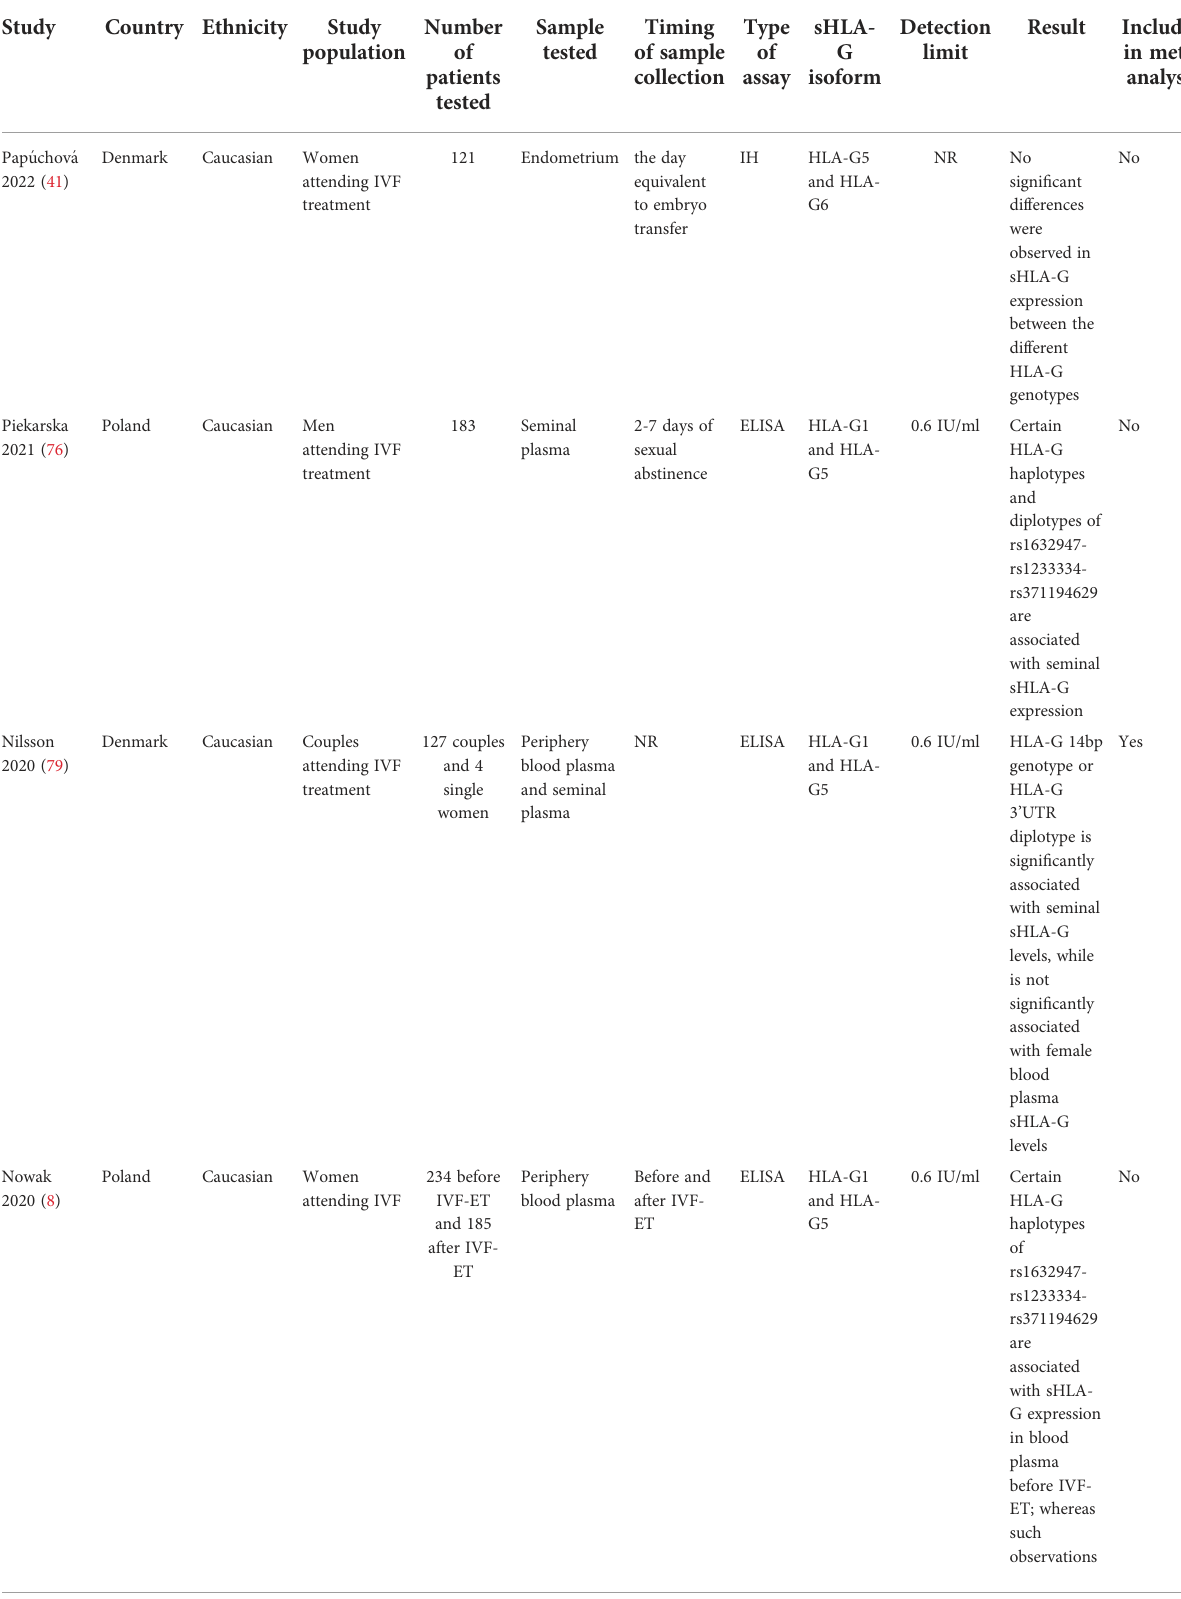
TABLE 3 Summary of the studies that reported the association of HLA-G polymorphisms with sHLA-G expression in patients attending IVF